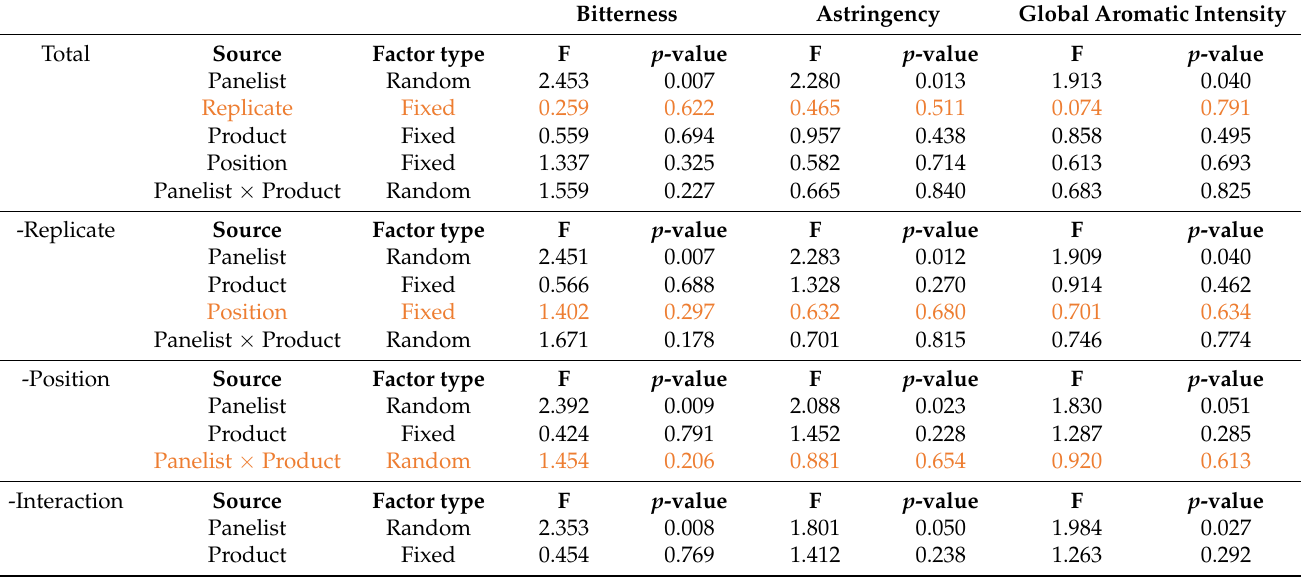
Table A4. Iterative simplification procedure used to assess the significance of the factors for each dependent variable (attribute) in PFC samples. Non-significant factors (in orange) were removed until significant parameters in the model were obtained. The level of confidence was set at